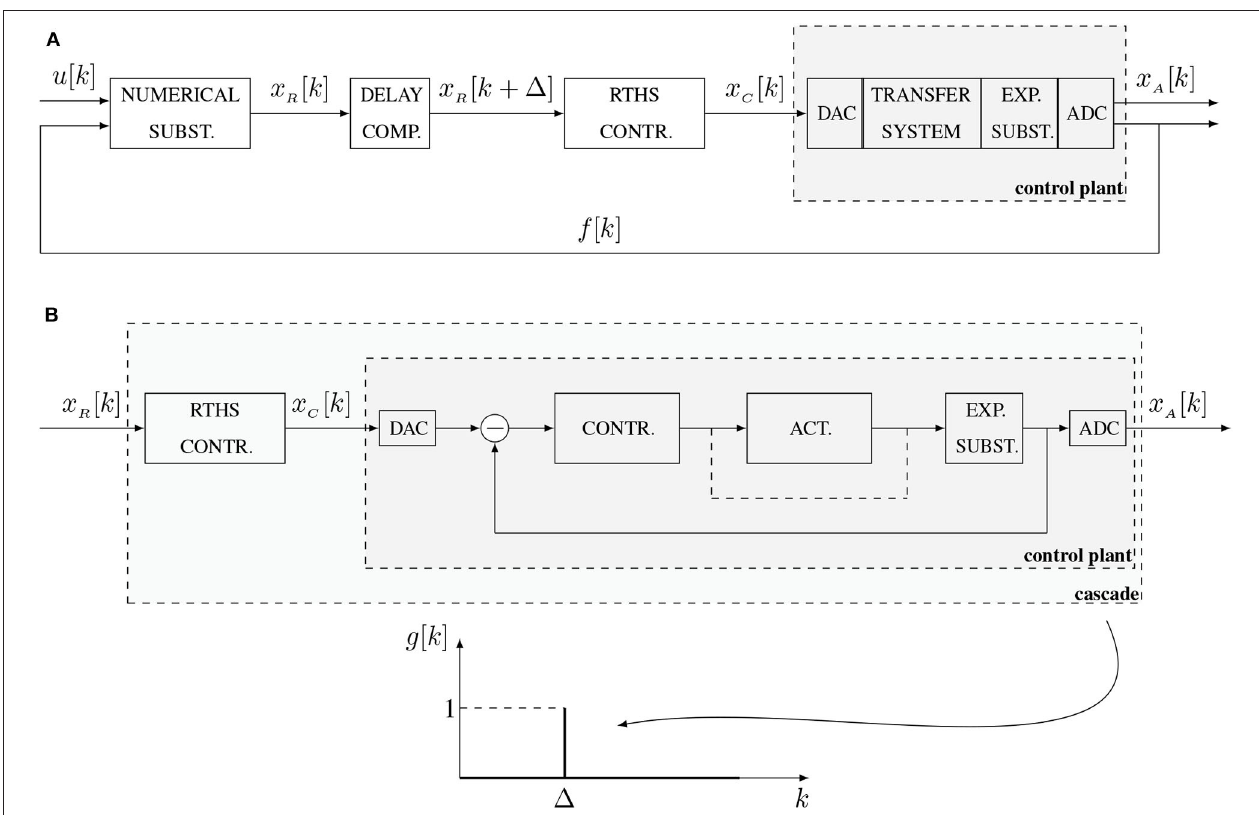
FIGURE 1 | Layout of the RTHS framework. (A) The RTHS loop. (B) The cascade of the RTHS controller and the control plant, which ideally should compose a delayed unit impulse.